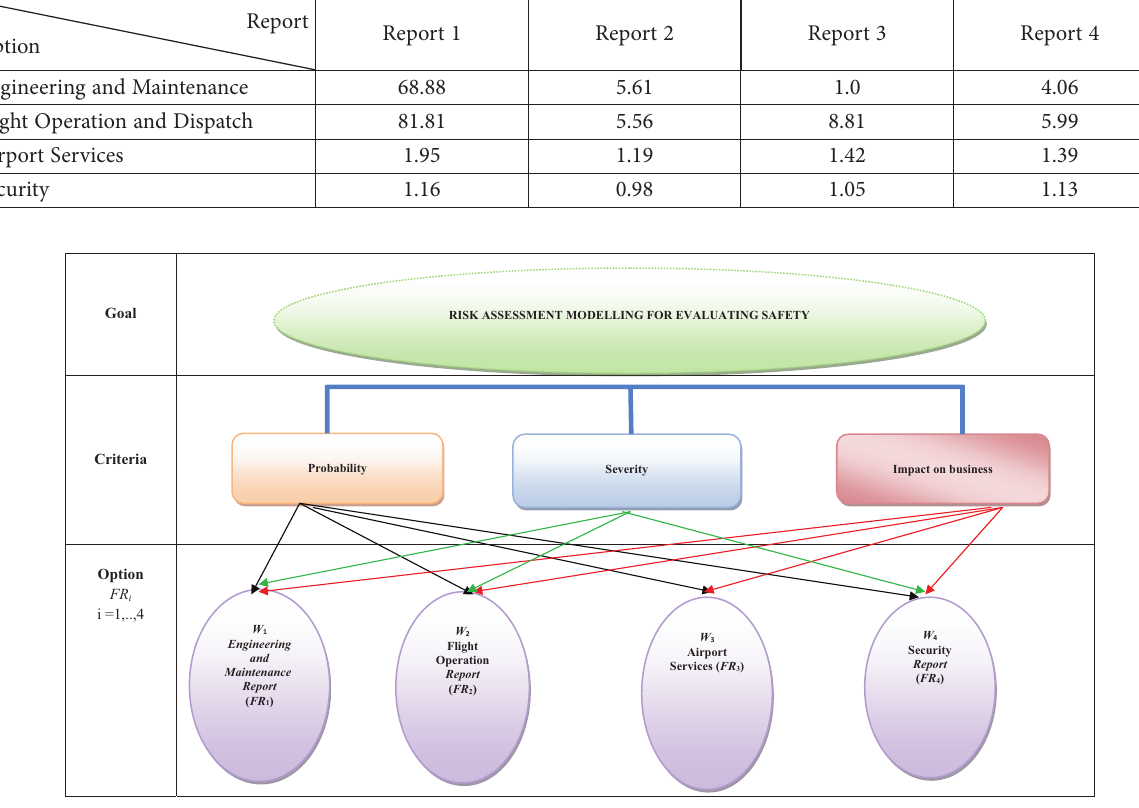
Figure 4. Goal decision tree for 3 dimensional parametric risk Table 6. Final safety index of the whole organization and